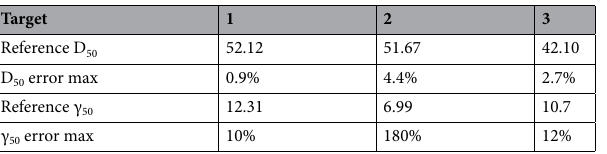
Table 2. Effect of image registration errors on D 50 and γ 50 values. Effect of imposing a ± 3 mm registration error in each superior-inferior, left–right and anterior–posterior direction on the dose response parameters: D 50 and γ 50 . The D 50 is robust to registration errors up to 3 mm in any direction, while γ 50 is very sensitive to such